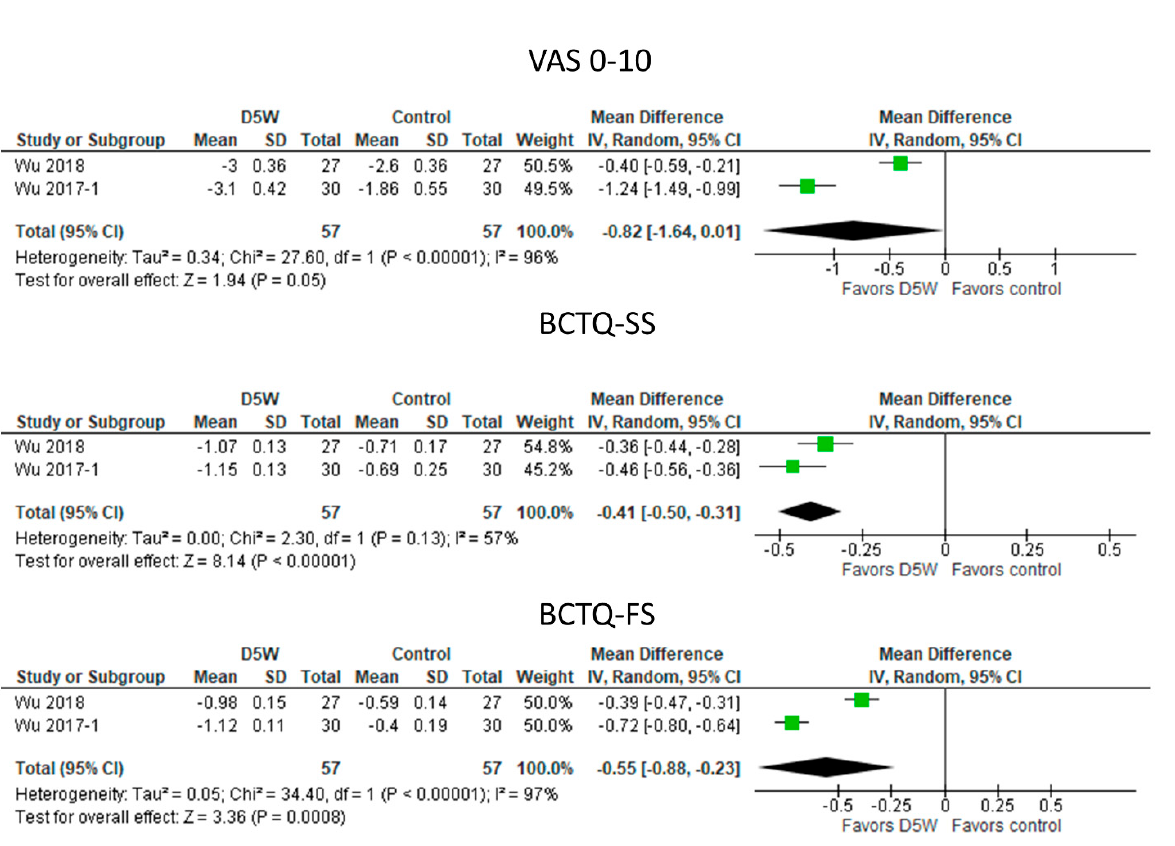
Figure 4. Meta—analysis of UPIT with D5W vs. control injections. VAS, visual analogue scale; BCTQ—SS, Boston Carpal Tunnel Questionnaire—symptom scale; BCTQ—FS, Boston Carpal Tunnel Questionnaire—functional scale. The green squares represent the differences between the means of each of the two groups compared, i.e., the mean differences. The size of the green square represents how much that individual study affects the overall outcome of the meta—analysis, i.e., the weight of the studies on the meta—analysis. The precision of the study depends on the 95% confidence interval for that mean difference, i.e., the length of the straight lines, the shorter the lines, the more precise the mean differences. The black trapezoid is the pooled mean difference of all the studies combined in consideration of the weight of each study, with its confidence interval extending from the left tip to the right tip.